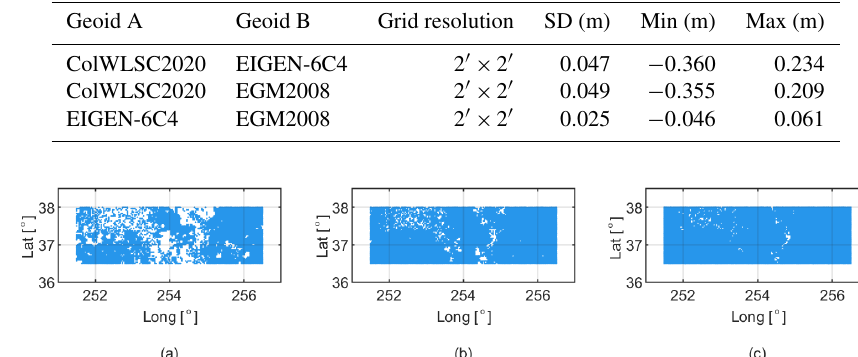
Figure 10. Agreement of the local Colorado geoid model with respect to both global models: (a) residuals below 1 σ , (b) residuals below 2 σ , and (c) residuals below 3 σ are shown in